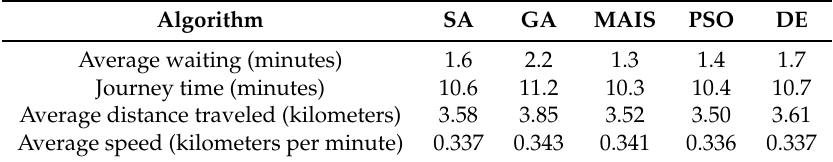
Table 2. Average results for travel metrics for both experiments.